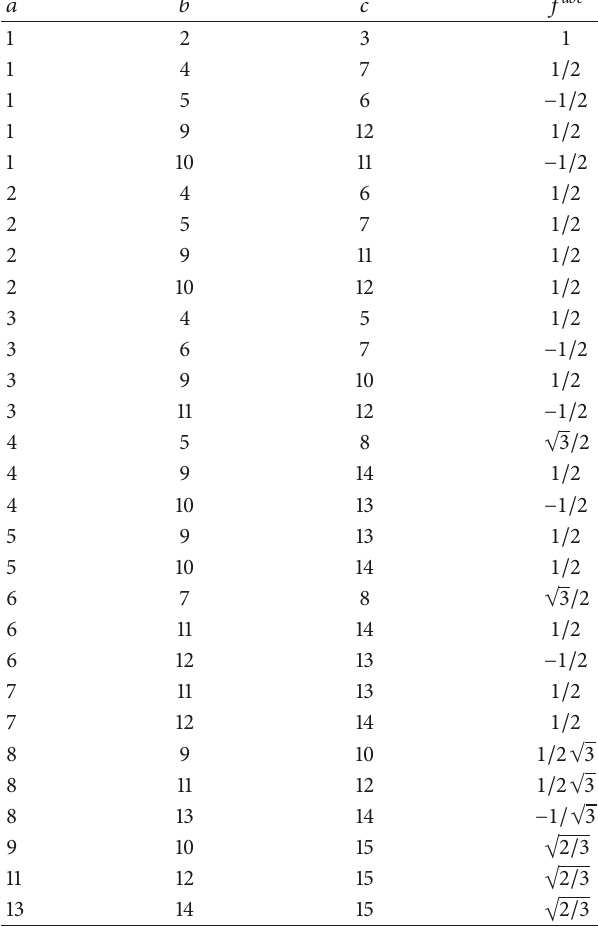
Table 1: The nonvanishing structure constants 𝑓 푎푏푐